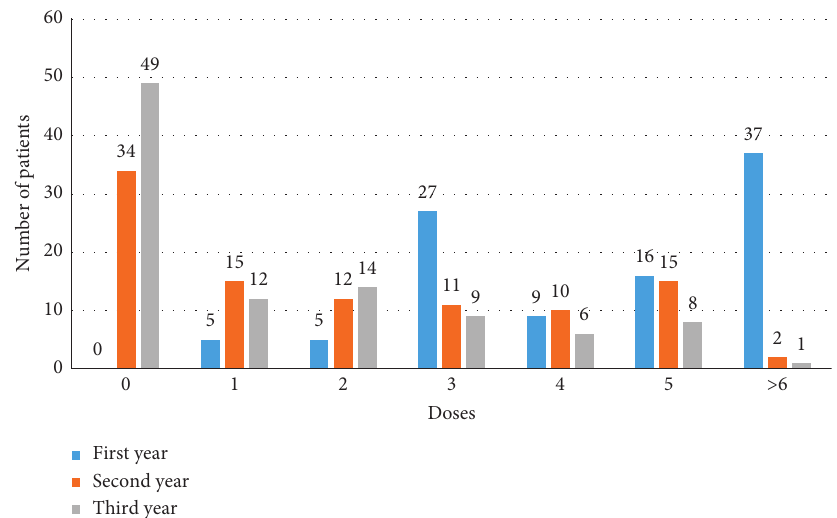
Figure 3: Number of injections at years 1, 2, and 3 in the complete 3-year follow-up group.